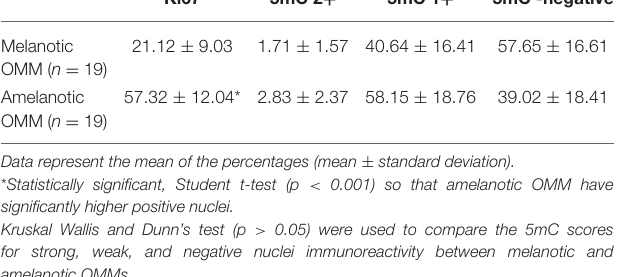
TABLE 3 | Summary data of the Ki67 and 5mC quantifications in melanotic and amelanotic OMM. Ki67